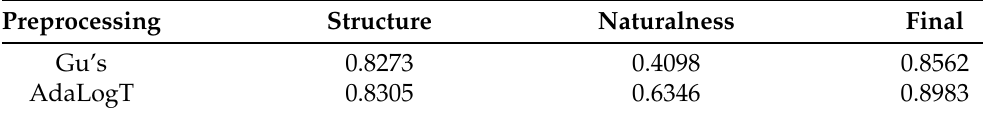
Table 2. Mean TMQI scores of luminance-domain algorithm.